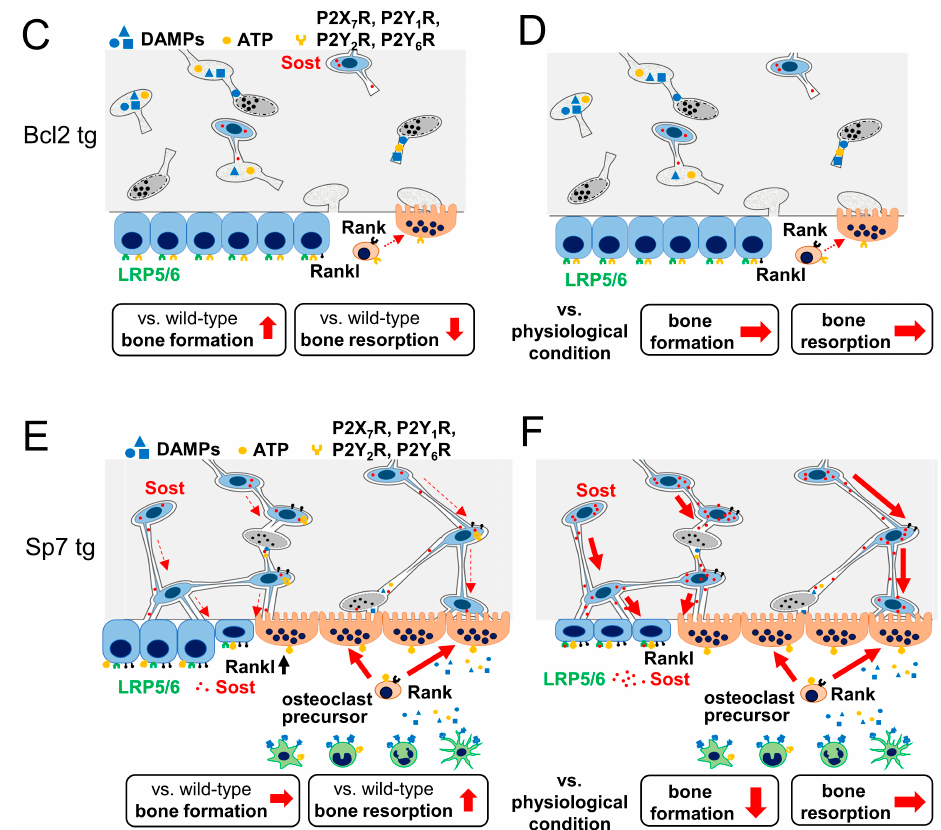
Figure 3. Bcl2 tg and Sp7 tg mice under physiological and unloaded conditions: In Bcl2 tg mice, the osteocyte network is disrupted by osteocyte apoptosis and their secondary necrosis due to reduced osteocyte processes and canaliculi ( A , C ). Sost is expressed in live osteocytes but cannot be released to the bone surface due to the interrupted lacunocanalicular network ( C ). Bone formation is increased, but bone resorption is decreased, and trabecular and cortical bone is increased in Bcl2 tg mice under physiological conditions ( A , C ). Sp7 tg mice have reduced osteocyte processes and canaliculi and 14% of osteocytes are TUNEL-positive ( A , E ). The lacunocanalicular network is functionally connected and secreted Sost reaches the bone surface ( E ). DAMPs from necrotic osteocytes, and ATP from apoptotic osteocytes are also likely to reach the bone surface and enhance bone resorption ( E ). Although bone formation in Sp7 tg mice is similar to that in wild-type mice, bone resorption is increased compared with wild-type mice due to osteocyte death under physiological conditions ( A , E ). In unloading, bone formation is reduced and bone resorption is increased, at least partly, through the increase in Sost and Rankl expression in osteocytes and osteoblasts, respectively, and Sost expression is increased in the compression side but not in the tension side of cortical bone in wild-type mice ( A , B ). Bone formation and resorption are unchanged by unloading in Bcl2 tg mice, and Sost expression in osteocytes in the compression and tension sides, and Rankl expression in osteoblasts are not altered by unloading ( C , D ). Sost expression is upregulated, bone formation is reduced, but bone resorption is unchanged by unloading in Sp7 tg mice ( E , F ). As a result, trabecular and cortical bone is reduced by unloading due to reduced bone formation in Sp7 tg mice ( E , F ). The dashed and solid arrows in the bone indicate a low and high amount of Sost secretion, respectively ( A , B , E , F